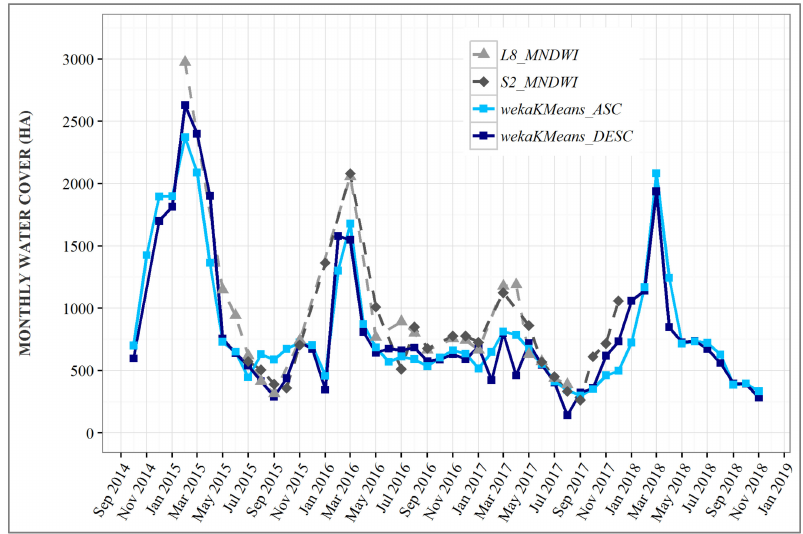
Figure 6. Monthly Sentinel-1 (both ascending and descending paths), Sentinel-2, and Landsat 8 water cover time-series between October 2014 and November